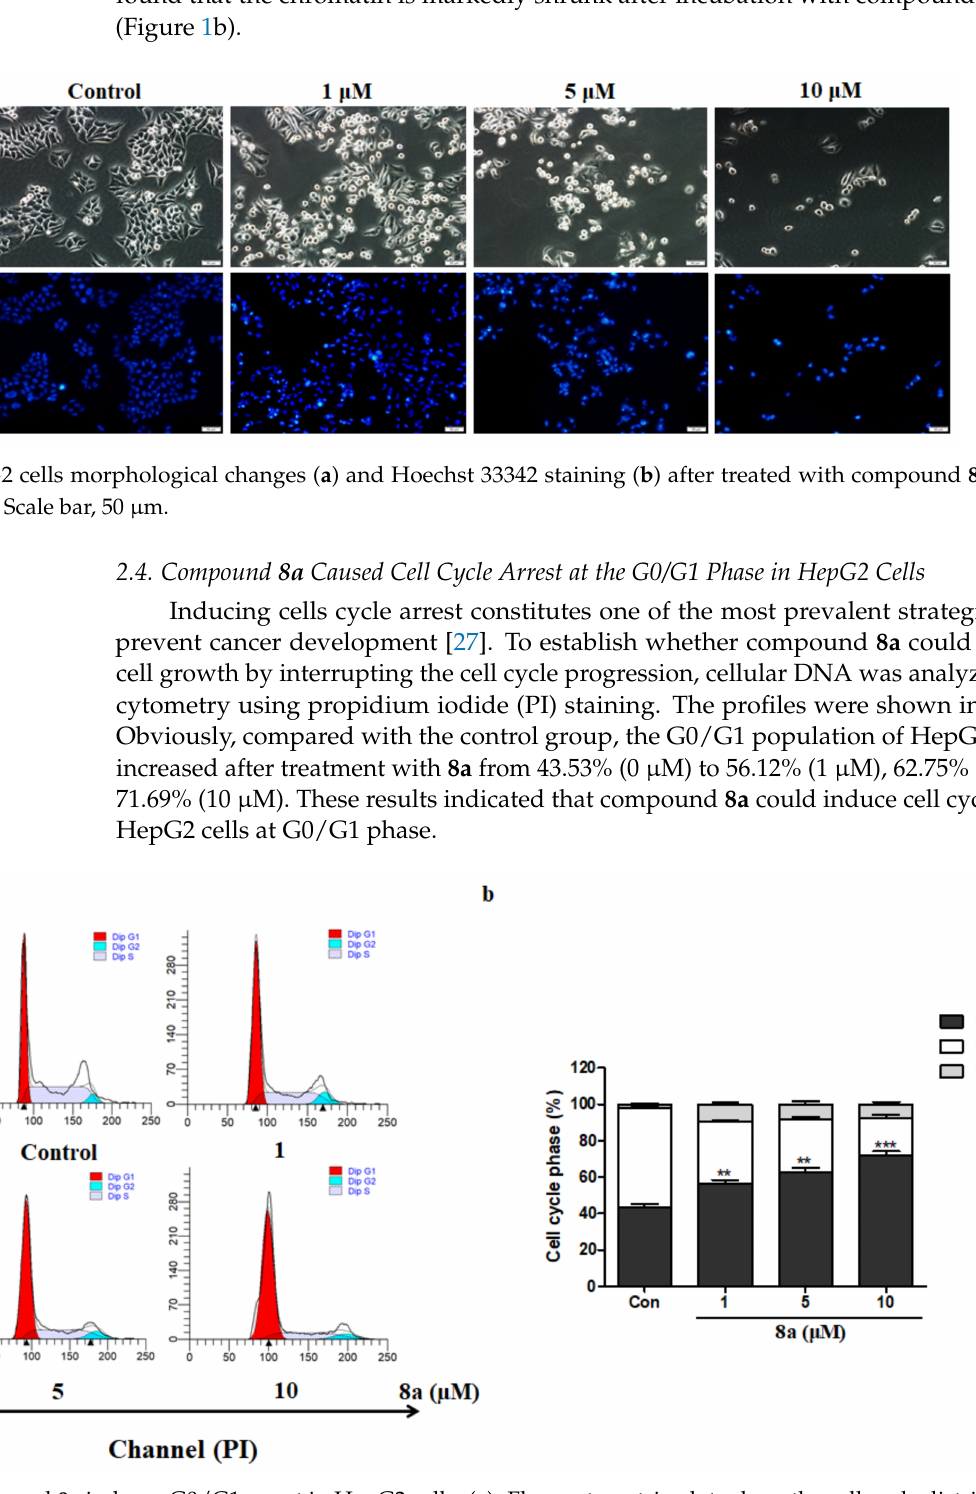
Figure 2. Compound 8a induces G0/G1 arrest in HepG2 cells. ( a ). Flow cytometric plots show the cell cycle distribution when the cells were treated with 8a (1, 5, 10 µ M) for 24 h; ( b ). Bar graphs show the cell cycle distribution when the cells were treated with compound 8a ; ** p < 0.01, *** p < 0.001 vs. the control group. All data are expressed as mean ± SD of the three independent